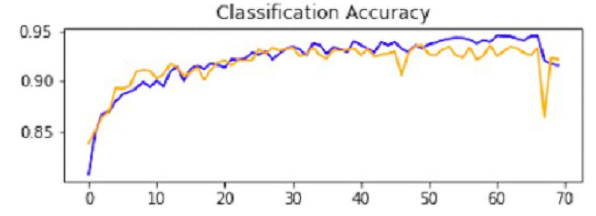
Figure 14. Classification accuracy of CNN2.